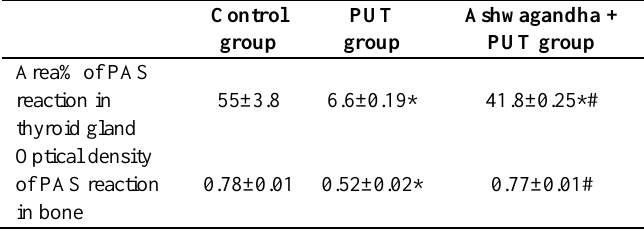
Control PUT Ashwagandha + group group PUT group 55±3.8 6.6±0.19*